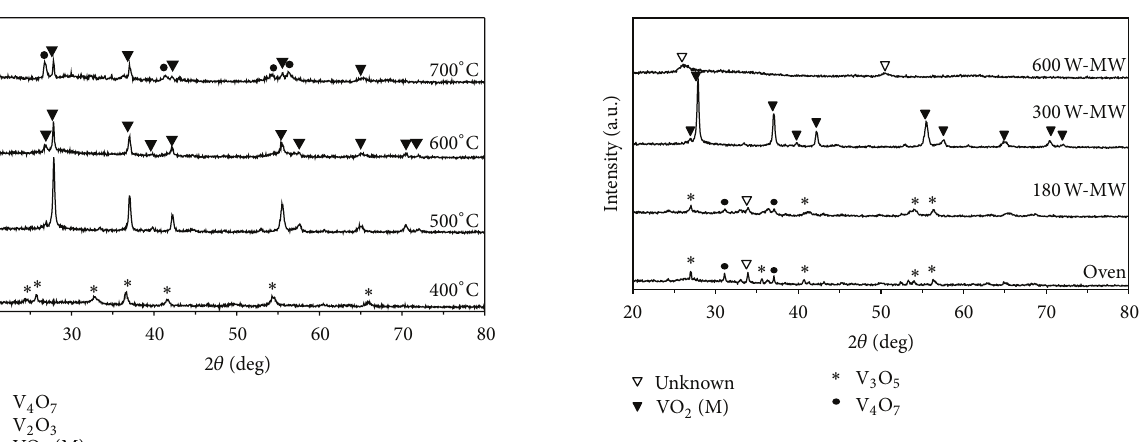
Figure4:XRDpatternsofvanadiumoxidepowderspreparedbythe microwave heating at different microwave irradiation powers and calcination at the temperature of 500 ∘ C for